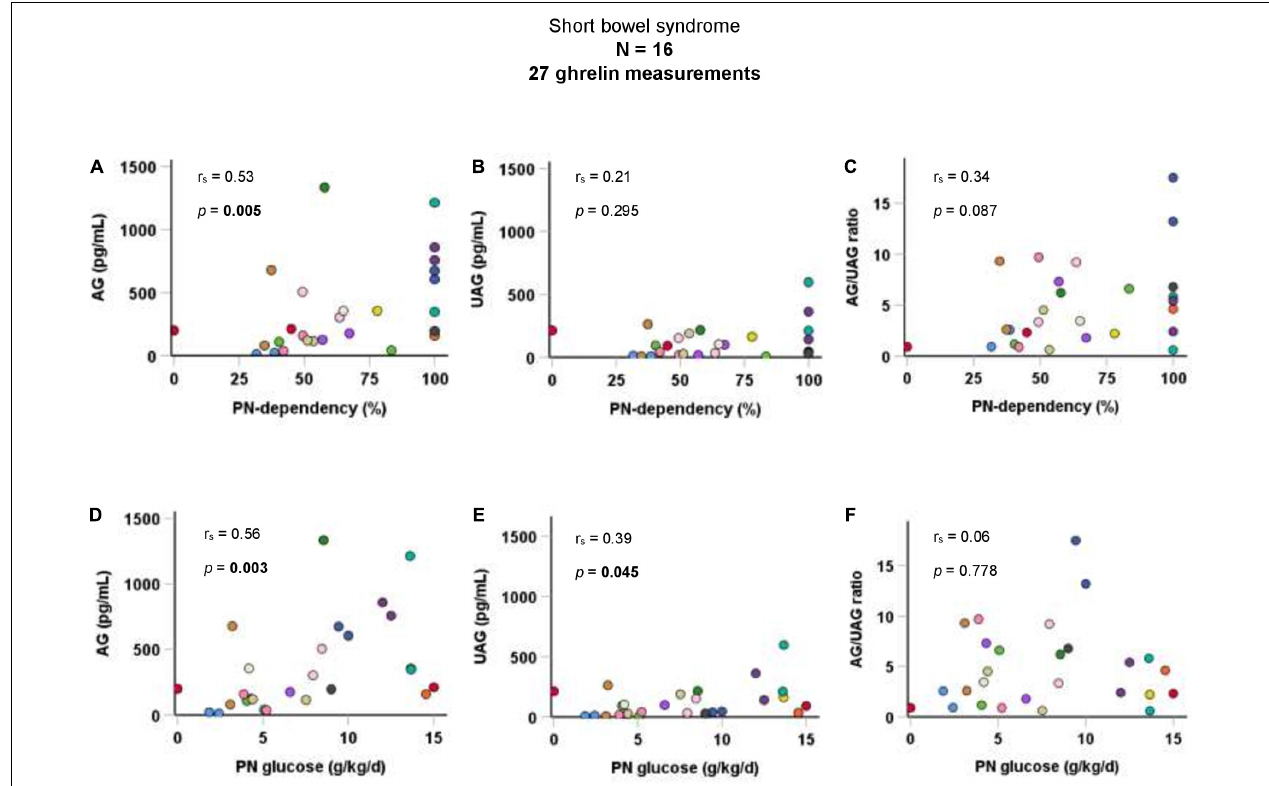
FIGURE 1 | Correlations of AG, UAG levels, and AG/UAG ratio with (A–C) PN-dependency, and (D–F) parenteral glucose intake in g/kg body weight per day in patients with short bowel syndrome. AG, acylated ghrelin; PN, parenteral nutrition; UAG, unacylated ghrelin. Every dot represents one ghrelin measurement. Dots in the same color are from the same patient. Correlations between variables were quantified using Spearman’s rho (r s ).